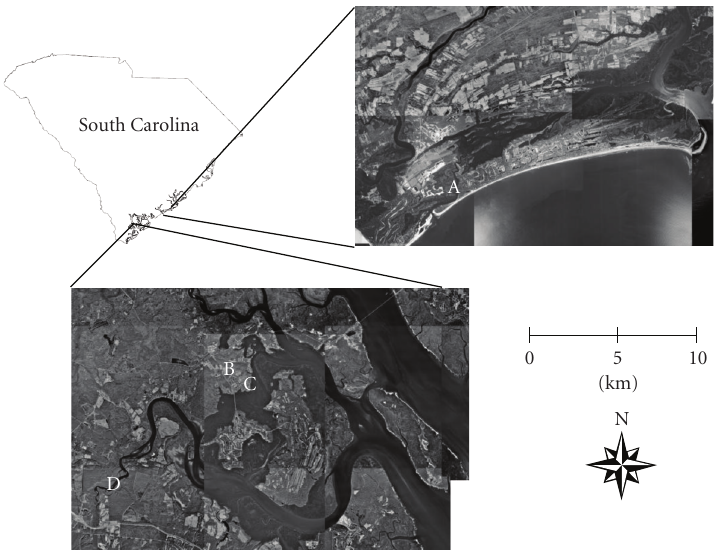
Figure 1: Sampling locations include the impacted (A) Oyster Rake and (B) Chechessee Creek Club golf course retention pond and the unimpacted (C) Chechessee Marsh and (D) Graves’